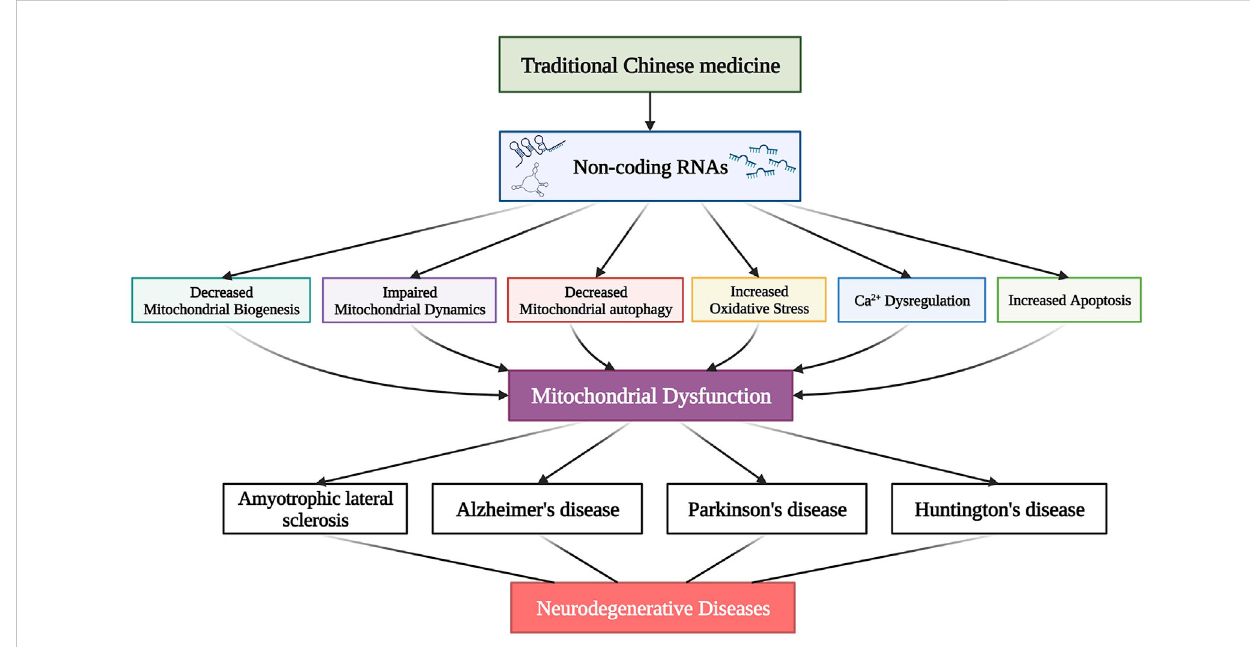
FIGURE 1 Traditional Chinese medicine (TCM) modulates mitochondrial dysfunction by directly acting on ncRNAs to alleviate various neurodegenerative diseases